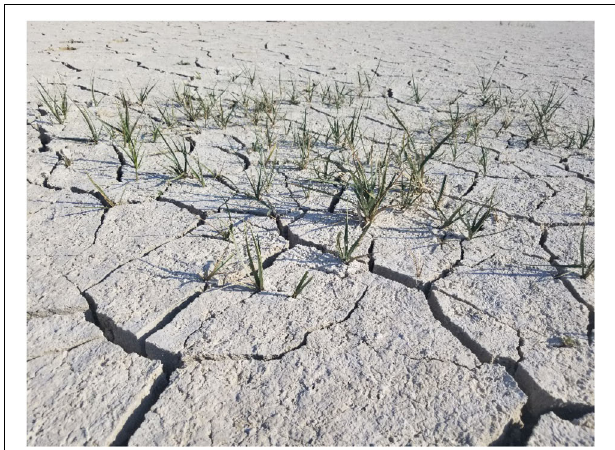
FIGURE 4 | “Ugly” sites, such as sites that are very dry or surrounded by invasive species, should not be over looked when collecting seeds for wetland restoration (Leger, 2008; Basey et al., 2015). Native species growing in these areas may harbor unique genotypes that allow them to survive in harsh conditions. These genotypes may be important if conditions are not ideal at a restoration site in current or future